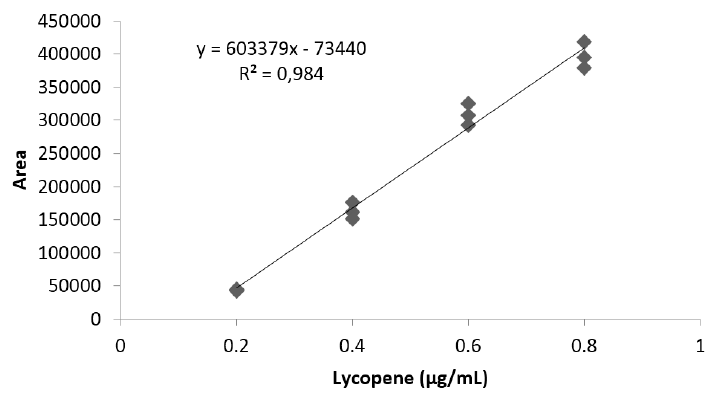
Figure 3. Representative standard curve obtained for